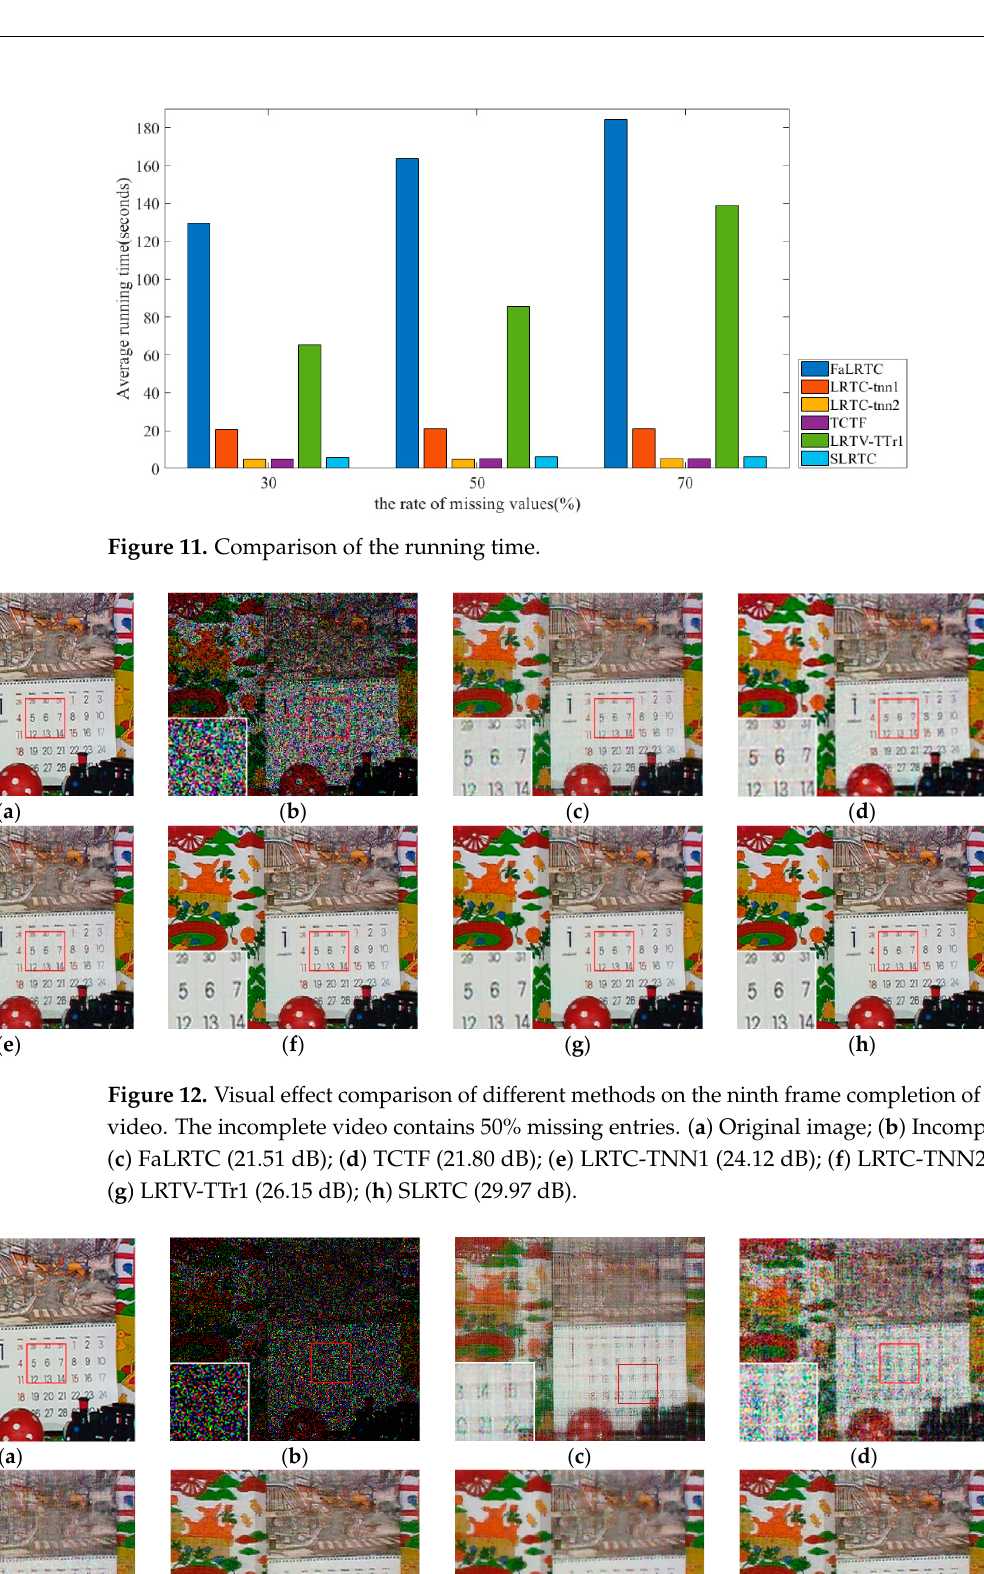
plete image contains 70% missing entries, shown as black pixels. ( a ) Original image; ( b ) Incomplete